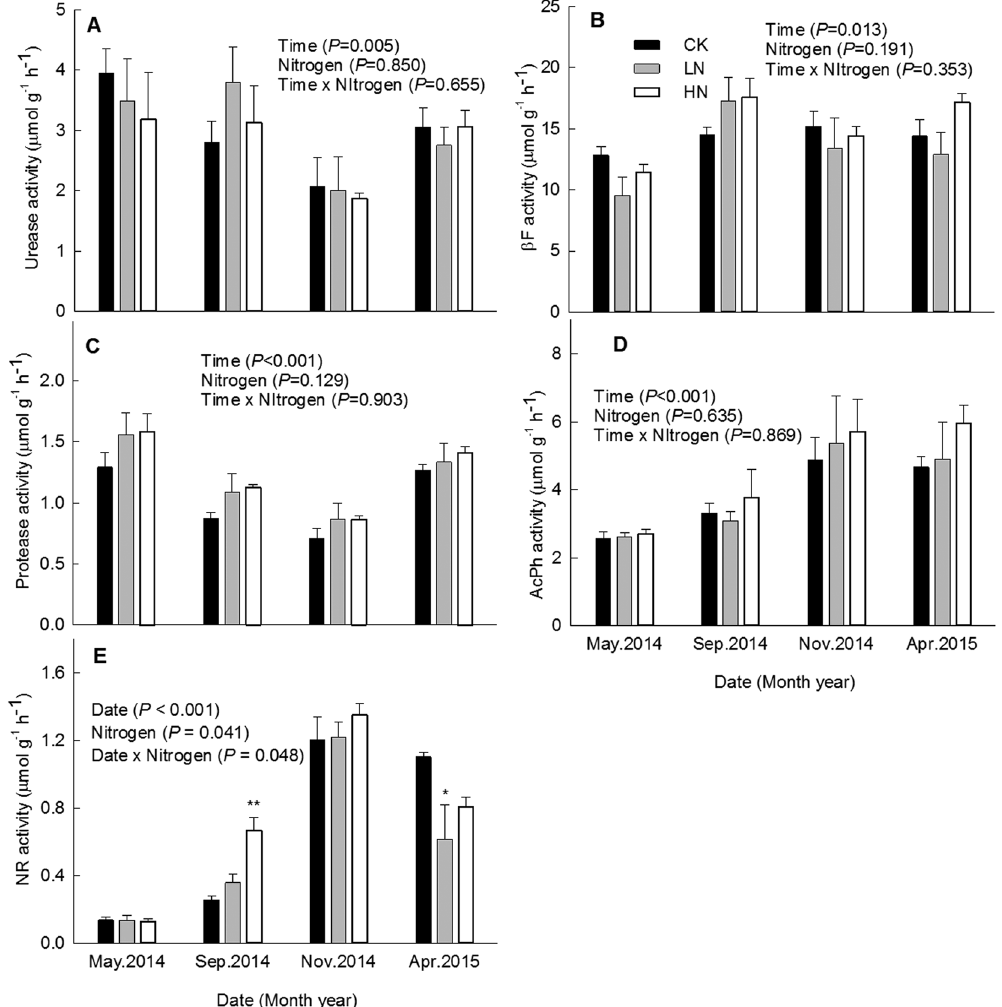
Figure 4. Soil enzyme activities under different nitrogen treatments in a secondary evergreen broad-leaved forest ecosystem in southwestern China. Values are means ± 1 SE. Error bars indicate ± 1 SE, N = 3. The results of repeated measures ANOVAs are shown for each parameter. Asterisk ( * ) indicate a significant difference between the control and experimental N treatment at P < 0.05; double asterisks ( ** ) indicate a significant difference between the control and experimental N treatment at P < 0.01.